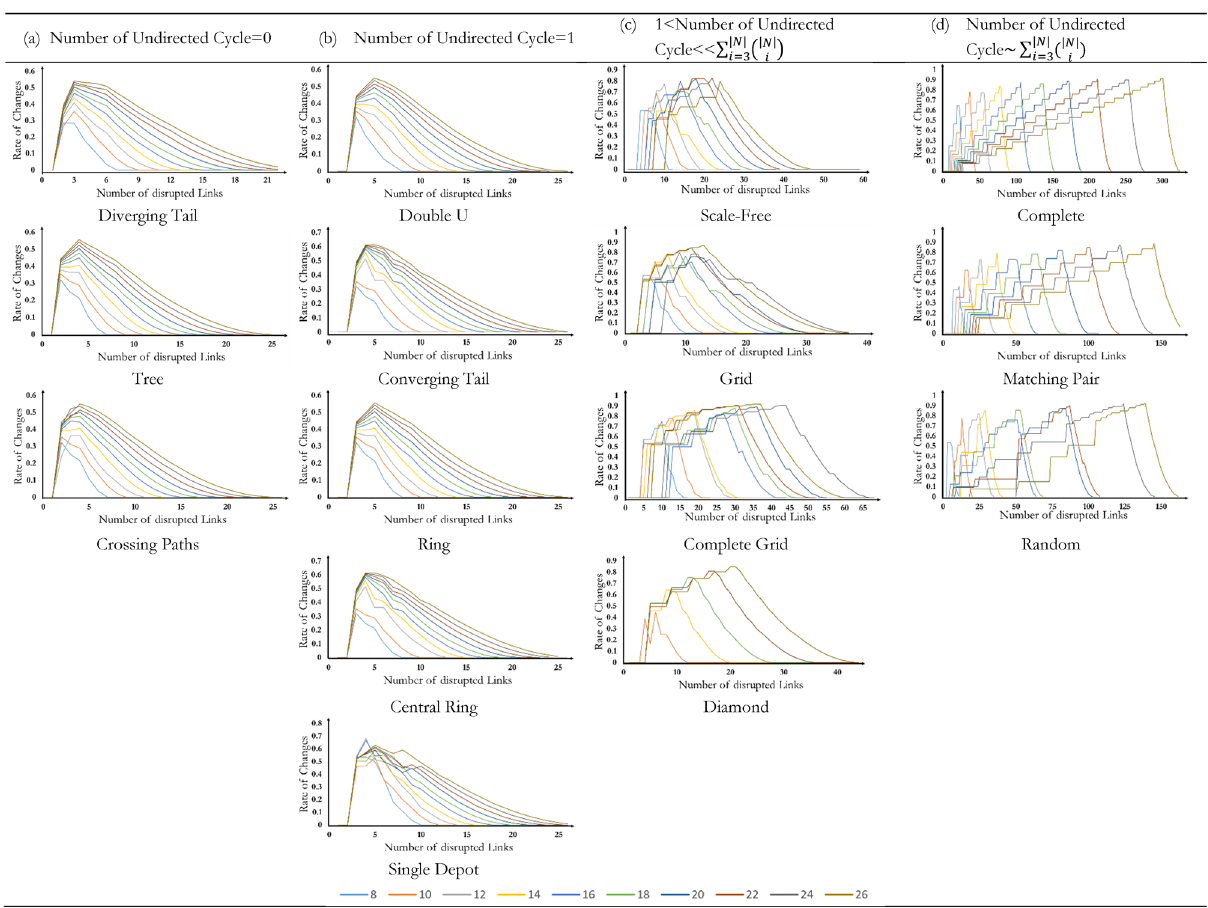
Figure 5. Trajectory of R(.) for 16 network topologies with 8 to 26 nodes but hub-and-spoke as its performance loss trajectory under benign attack is the same as its performance loss trajectory under malicious attack. ( a ) Regardless of topological characteristics, the rate of change in networks with no cycle follows a polynomial trajectory with a degree of four. ( b ) The existence of one cycle would not change the regression function but shift the trendline one unit forward. ( c ) The network topologies follow polynomial functions with the degree of five. As the number of cycles increases, the skewness of the regression function decreases. Among networks with the | N | | N | number of cycles ≪ , complete grid networks have the lowest skewness. ( d ) The network topologies i = 3 i (cid:30) (cid:29) (cid:31) follow polynomial trendlines with a degree of five. The completeness of network topology means negative